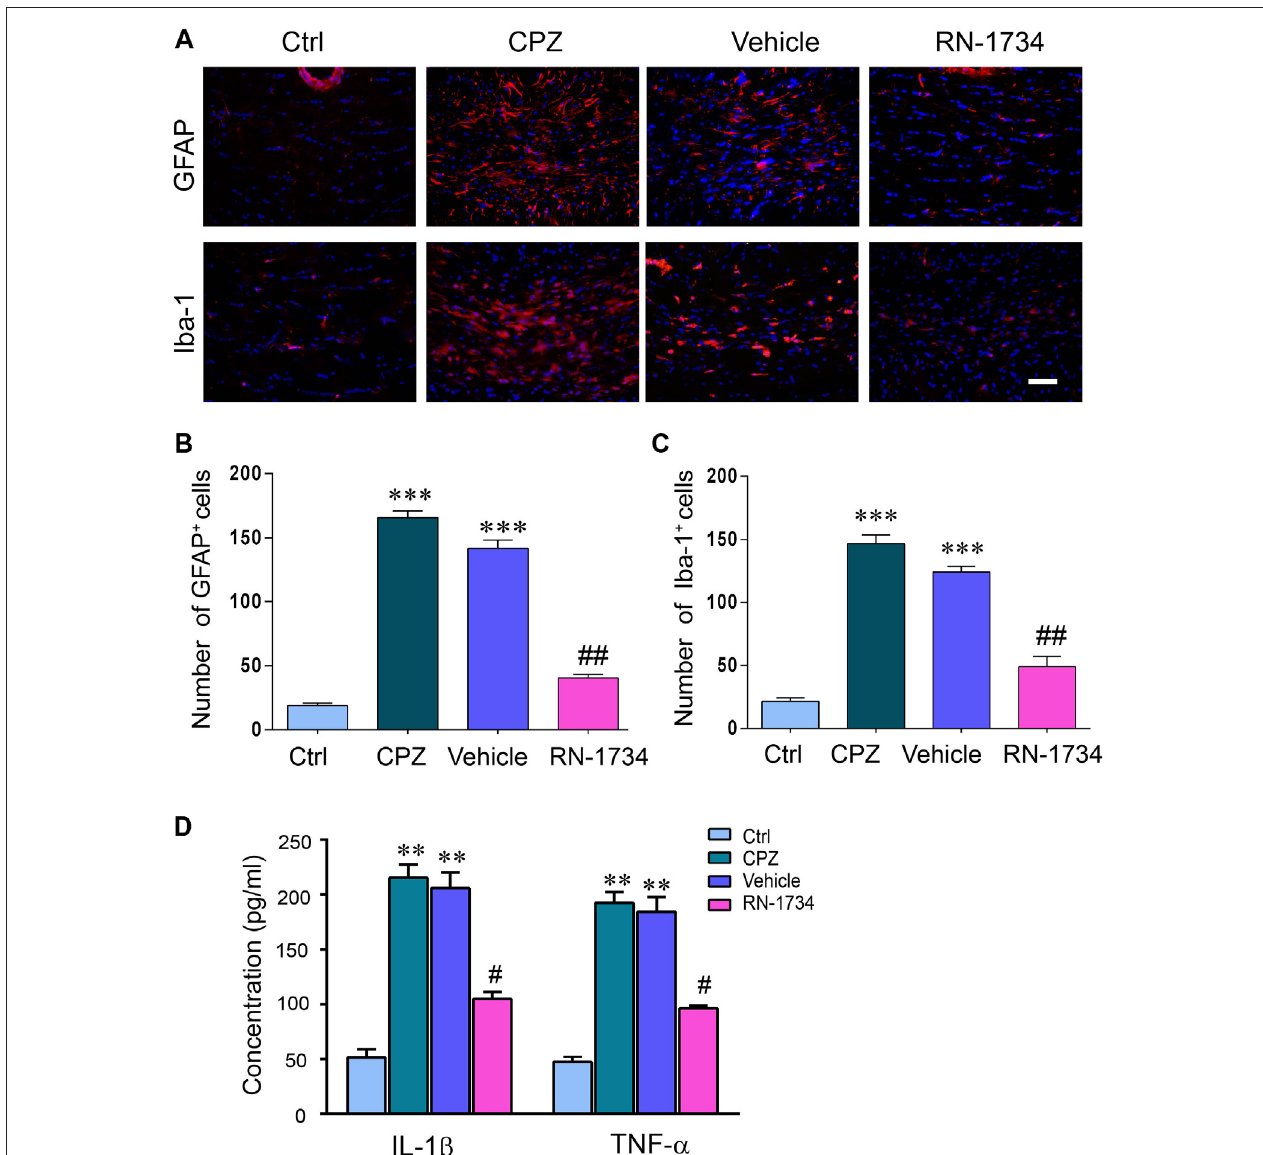
FIGURE 3 | TRPV4 activation was involved in glial activation and proinflammatory cytokines release. (A) Representative glial fibrillary acidic protein antibody (GFAP) and Iba-1 immunofluorescent images for the corpus callosum. Scale bar = 20 µ m. (B,C) Quantitative analysis of GFAP- and Iba-1-positive cell numbers. The increased numbers of GFAP- and Iba-1-positive cells were reversed by the TRPV4 inhibitor RN-1734 ( n = 4). (D) Protein levels of tumor necrosis factor alpha (TNF- α ) and interleukin 1beta (IL-1 β ) were detected by enzyme-linked immunosorbent assay (ELISA) ( n = 3). The data are expressed as the mean ± SEM. ∗∗ P < 0.01, ∗∗∗ P < 0.001 vs. the Ctrl group; # P < 0.05, ## P < 0.01 vs. the vehicle